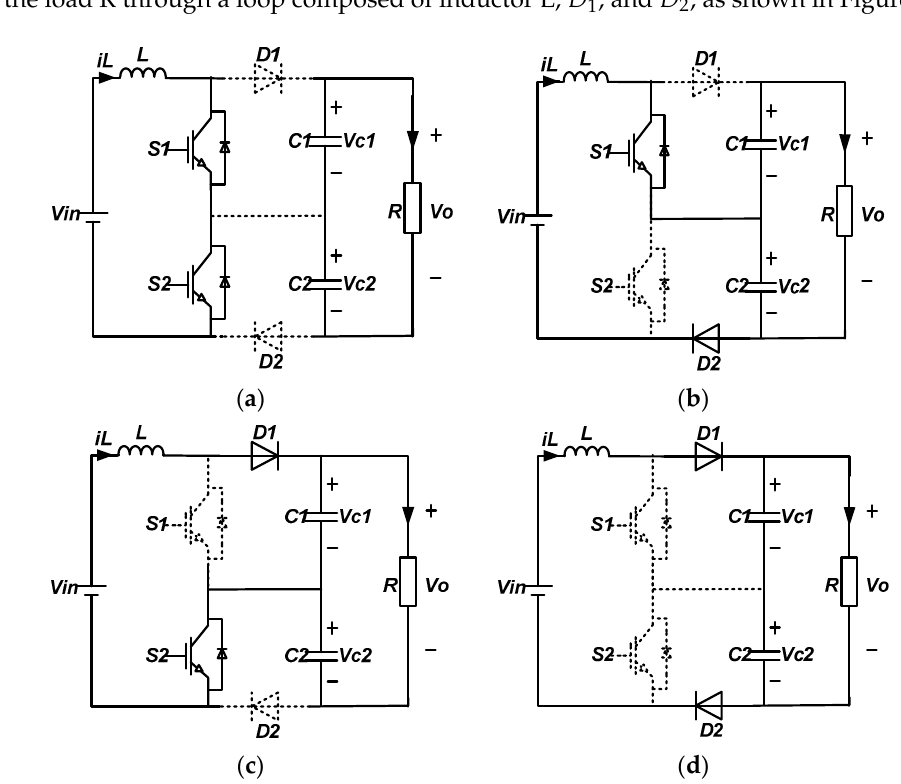
Figure 3. Four operating modes of boost-TL converters.